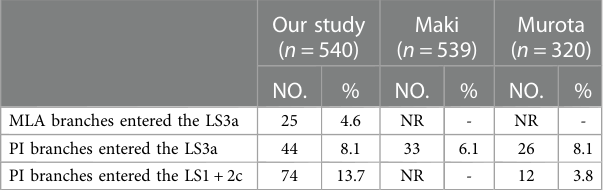
TABLE 8 The branches of the lingular segment artery entered the LS1+2 and LS3.